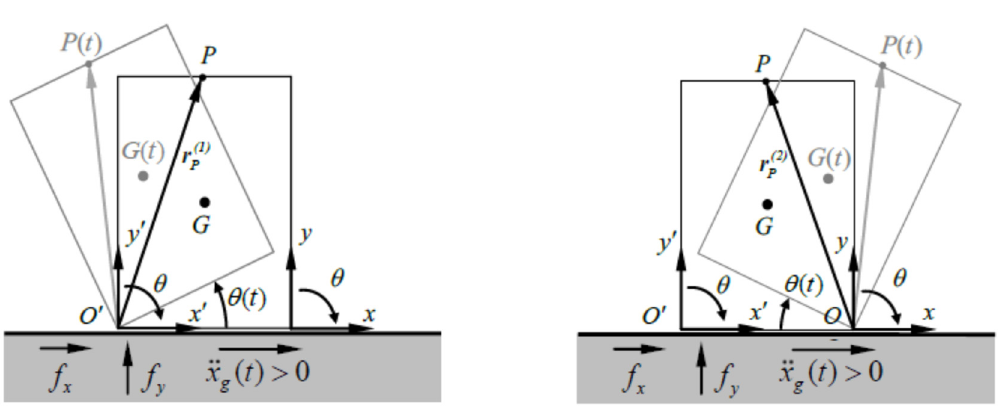
Figure 2. The Housner rocking model with 𝑅 (cid:2869) = {𝑂, 𝑥, 𝑦} for 𝜃(𝑡) > 0 and 𝑅 (cid:2870) = {𝑂 (cid:4593) ,𝑥 (cid:4593) , 𝑦 (cid:4593) } for 𝜃(𝑡) < 0 [36]